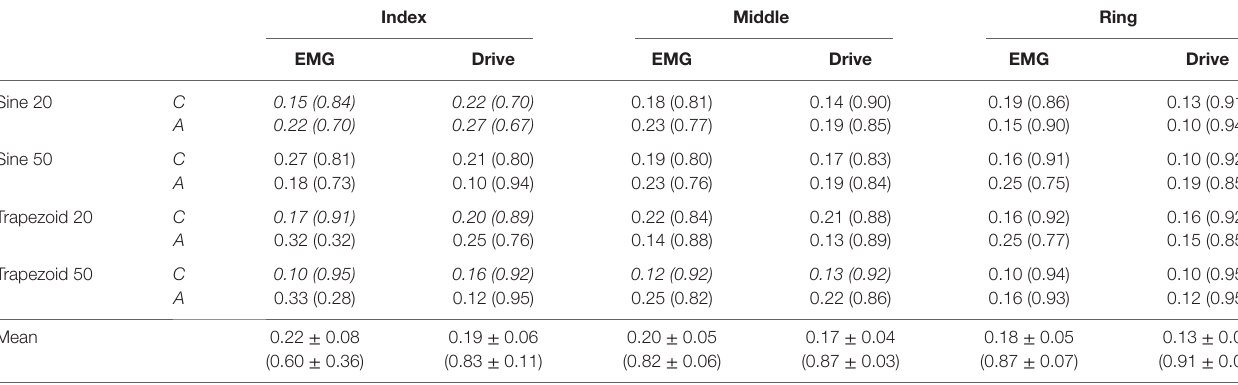
taBLe 1 | Overall results of the root-mean-square error (RMSE) and correlation